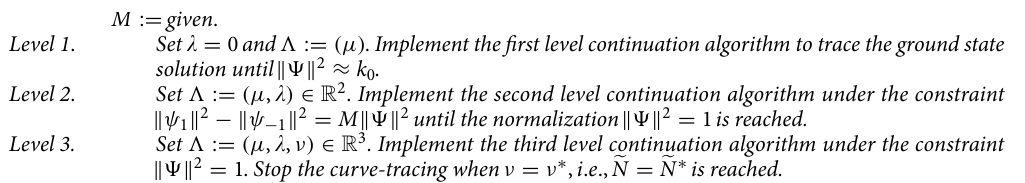
Table 1 lists the parameters and the associated constraints used in Algorithm 3.2, and the counterparts used in 40 .